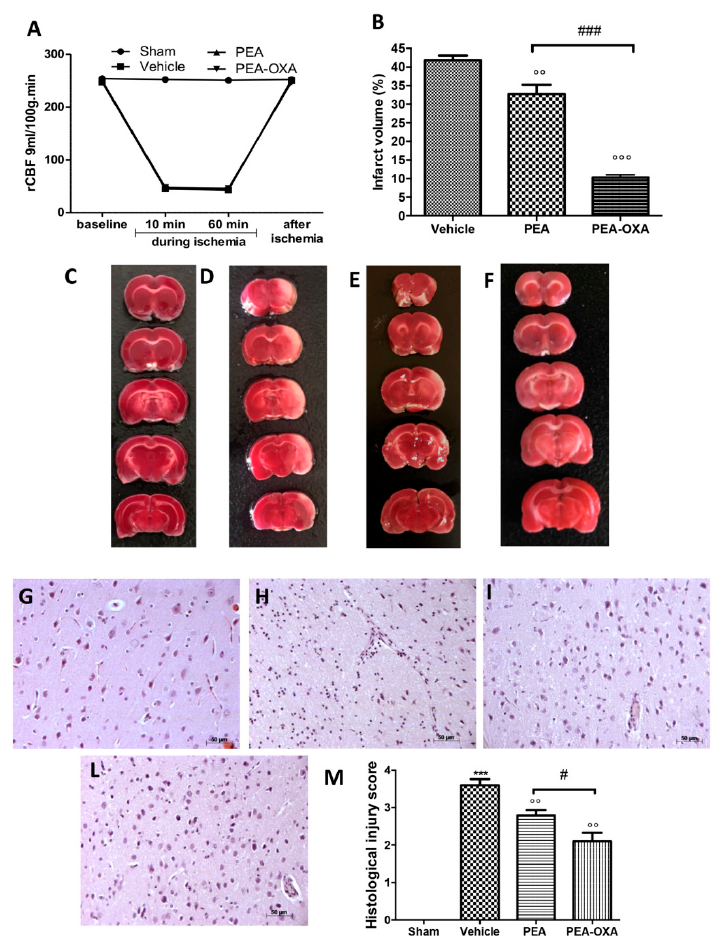
Figure 1. Efficacy of PEA-OXA on rCBF and the ischemic area induced by transient MCAo: rCBF was controlled to confirm the success of the induction of the transient ischemia. This was monitored at baseline (10 min before), at 10 and 60 min during ischemia, and 5 min after ischemia ( A ). TTC staining of brain sections was performed 24 h after MCAo. Tissues from vehicle-treated animals displayed the presence of an unstained area ( B,D ) compared to the sham group ( B,C ). PEA-OXA administration ( B,F ) reduced this infarcted area more effectively than did the PEA treatment ( B,E ). A histological analysis of brain samples from vehicle-treated rats revealed the loss of neurons ( H,M ) compared to the sham group ( G,M ), which was ameliorated by PEA administration ( I,M ). PEA-OXA administration displayed more protective effects compared to the PEA treatment ( L,M ). For the histology, a 20× magnification is shown (50-µm scale bar). A p -value of less than 0.05 was considered significant: * p < 0.05 versus sham; ° p < 0.05 versus vehicle; ** p < 0.01 versus sham; °° p < 0.01 versus vehicle; *** p < 0.001 versus sham; °°° p < 0.001 versus vehicle; # p < 0.05 versus PEA; ## p < 0.01 versus PEA; ### p < 0.001 versus PEA.